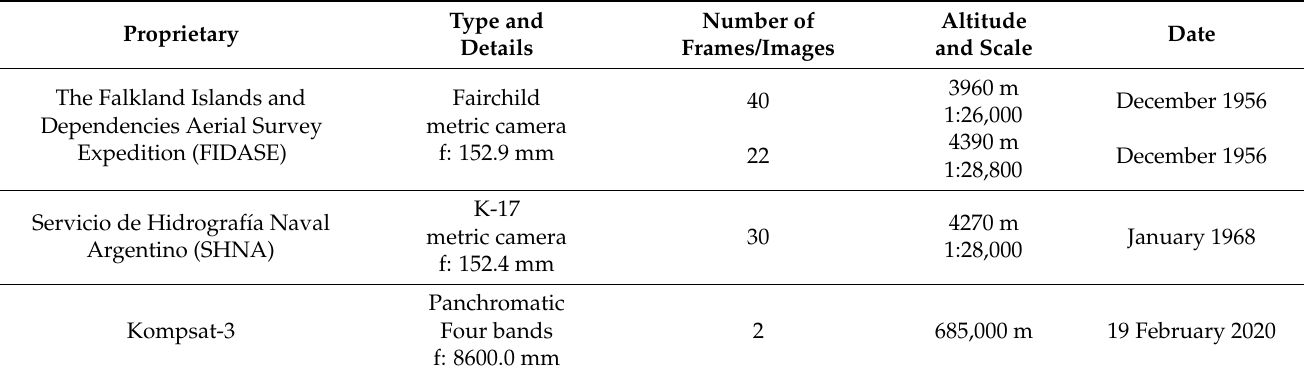
Table 1. Applied imagery material